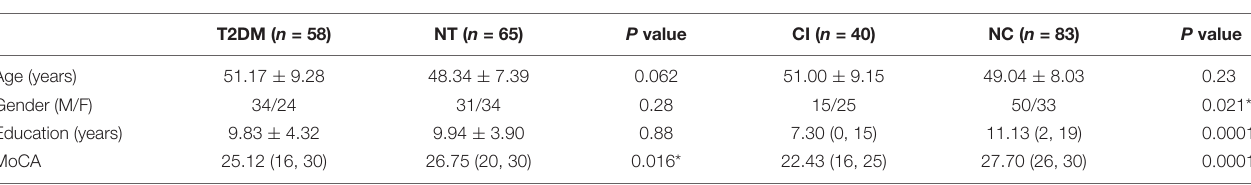
TABLE 1 | Comparison of clinical characteristics between two